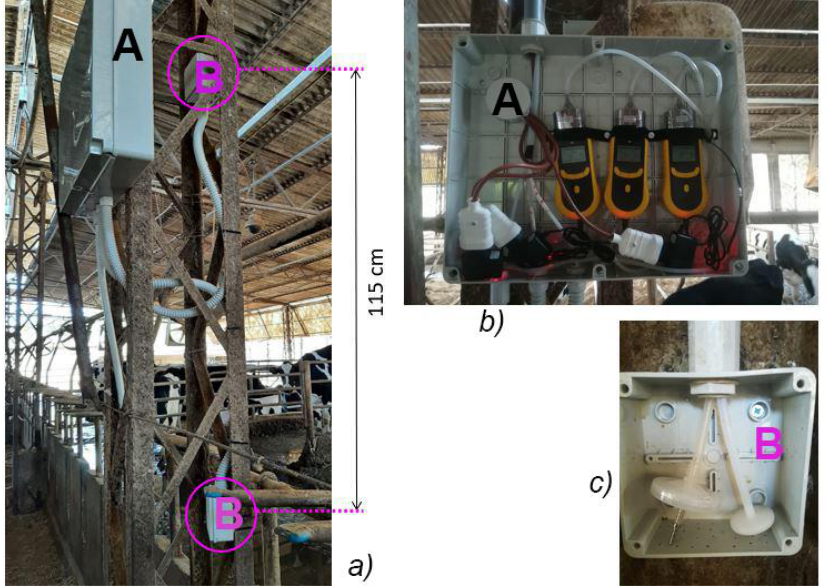
Figure 3. Installation of the low-cost system in the barn ( a ) with a large box (A) to contain the three low-cost measurement devices and small perforated boxes (B) to contain the sampling points for the measurements. The distance between two different consecutive sampling points was 1.15 m ( a ). In the large box ( b ), three low-cost measurement devices were installed. In the small boxes ( c ), the sampling points for the measurement are shown. In detail, each small box contained the sampling tubes for both the low-cost and reference devices. Each sampling tube was equipped with an air filter.